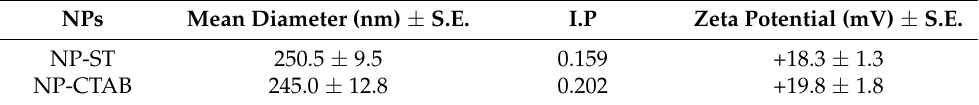
Table 5. Mean diameters and Zeta potential values of NP-ST and NP-CTAB. NPs